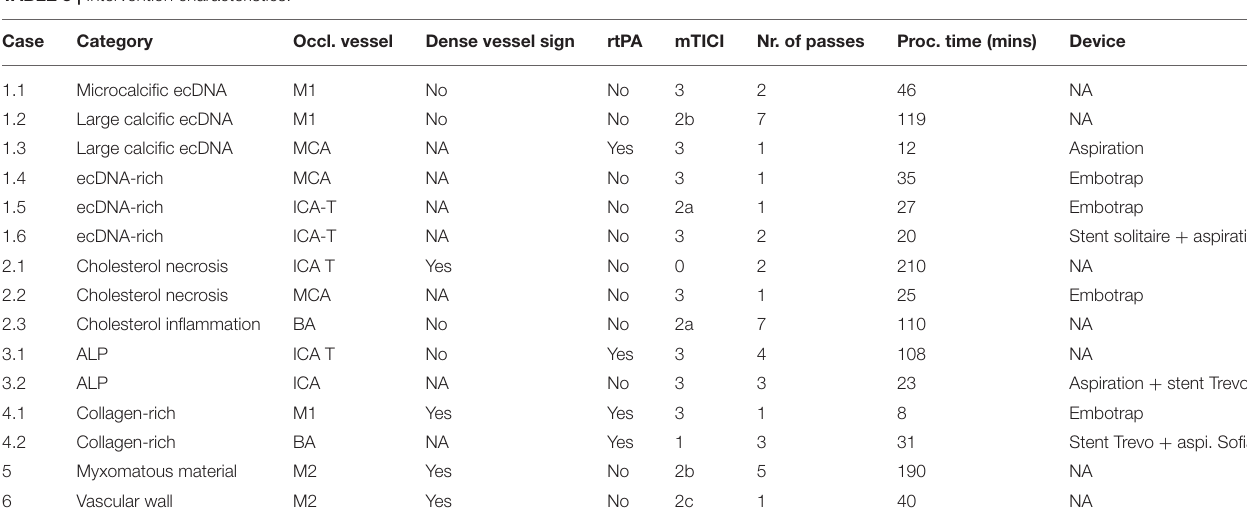
TABLE 3 | Intervention characteristics.